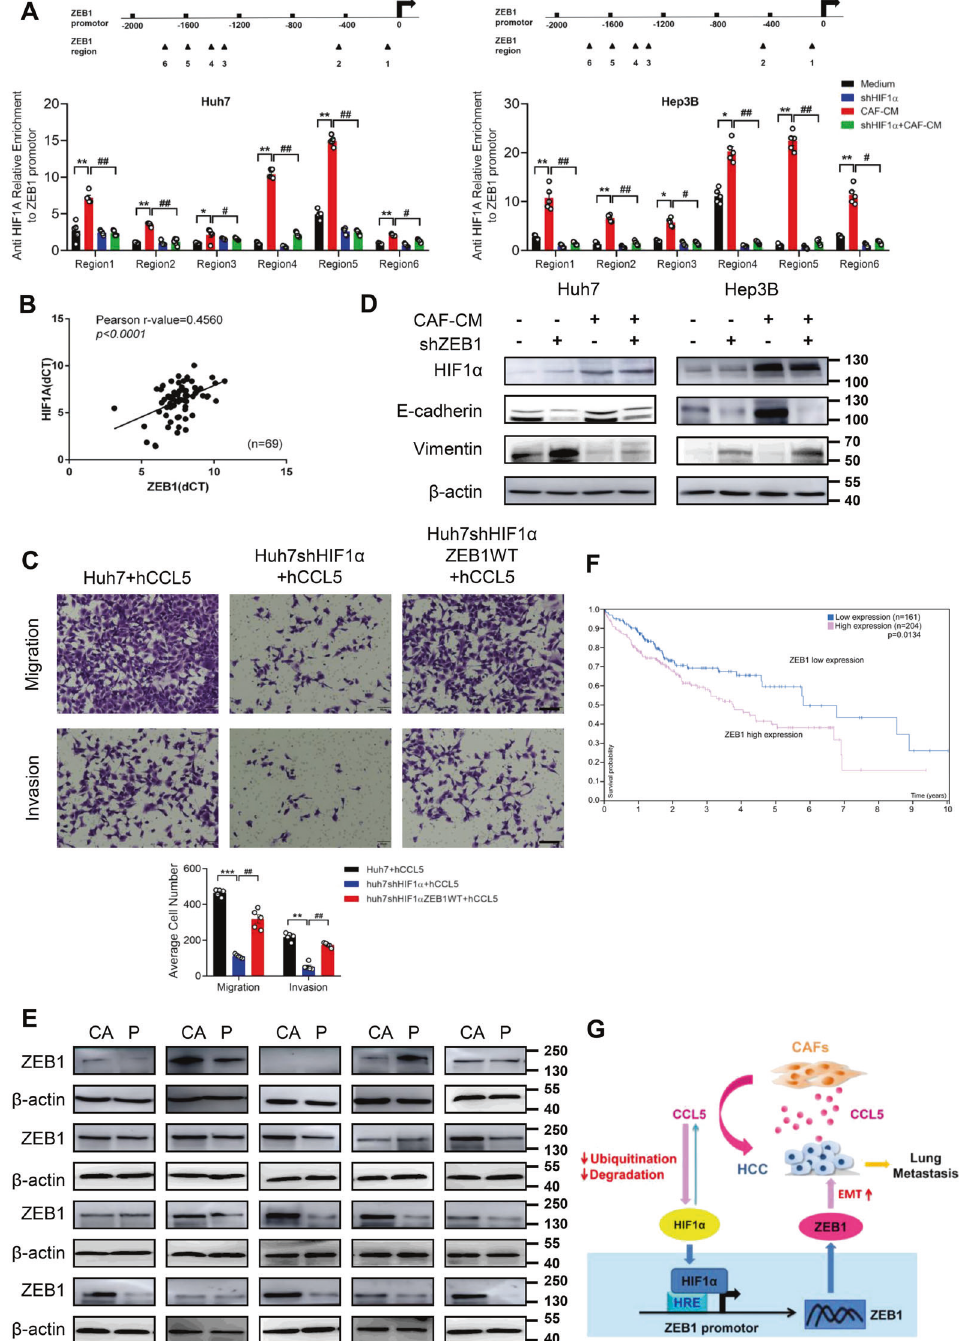
Fig. 7 ZEB1 is a possible downstream factor of HIF1 α . A ChIP assay detected the relative enrichments of DNA bound to ZEB1 promoter at six binding sites in Huh7 and Hep3B cells treated with CAF-CM as well as correspongding HIF1 α knockdown cells. Mean ± SD, * p < 0.05, ** p < 0.01, compared with the tumor control group. # p < 0.05, ## p < 0.01, compared with the CAF-CM group. B Pearson correlation analysis showed that HIF1A was positively correlated with the expression of ZEB1 in 69 HCC samples ( r = 0.4560, p < 0.0001). C The migration and invasion abilities of ZEB1-overexpressing HIF1 α knockdown (ZEB1-shHIF1 α ) Huh7 cells treated with hCCL5 (100 ng/ml) were detected by transwell assay. Scale bar: 50 μ m. N = 5 per group. Mean ± SD, ** p < 0.01, *** p < 0.001, compared with Huh7 + hCCL5 group. ## p < 0.01, compared with the Huh7shHIF1 α + hCCL5 group. D ZEB1 was knocked down in Huh7 and Hep3B cells pretreated by CAF-CM or not, and the expression of HIF1 α and EMT markers was detected using western blotting. E ZEB1 expression in cancer tissues and matched tumor-adjacent tissues of 20 liver cancer patients was detected by western blotting. F Survival analysis showed overall survival of patients with high and low levels of ZEB1 expression ( P = 0.0134, log-rank test, https://www.proteinatlas.org/ENSG00000148516-ZEB1/). G Graphical illustration of the mechanism by which CAF-derived CCL5 inhibited the ubiquitination degradation of HIF1 α and up-regulated the downstream ZEB1 to promote liver cancer metastasis.